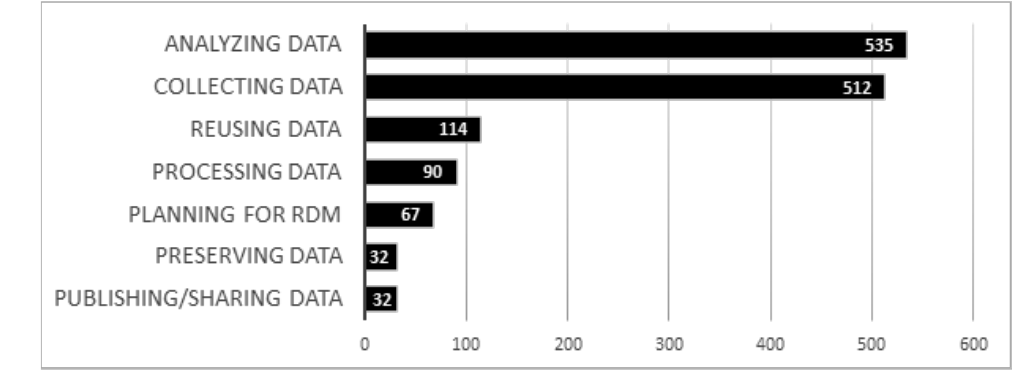
Figure 1 Data management life cycle codes